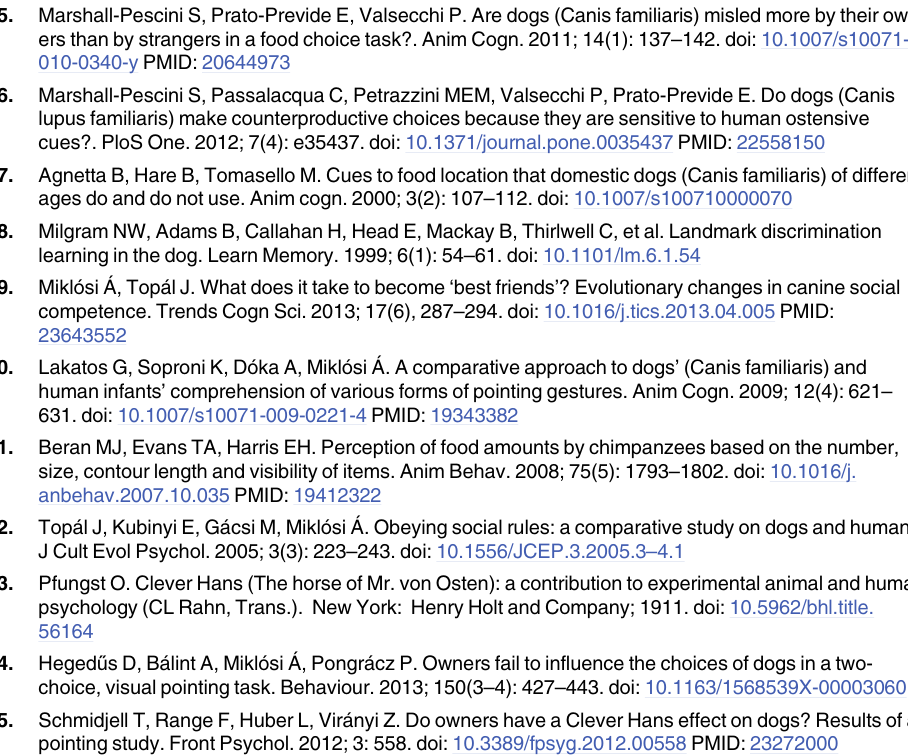
PLOS ONE | DOI:10.1371/journal.pone.0134575 August 4,